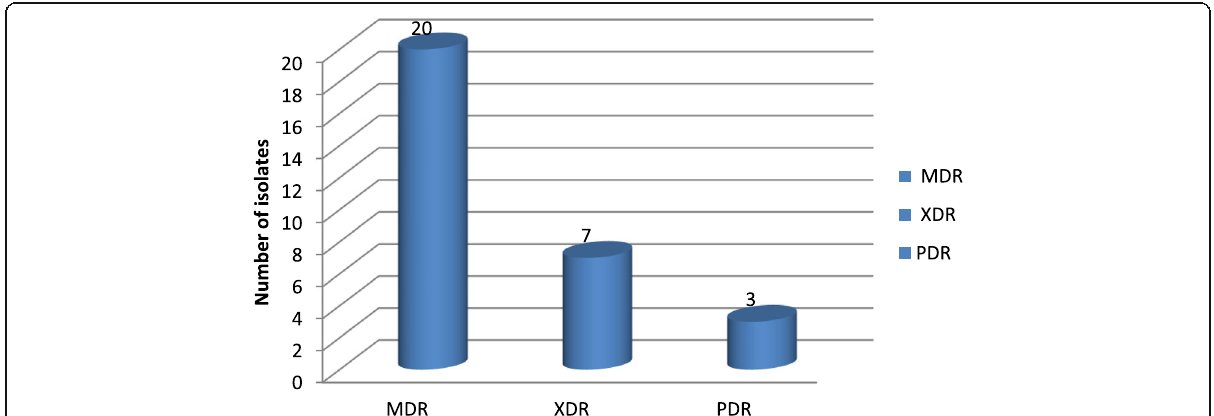
Fig. 2 Number of MDR, XDR, and PDR bacterial isolates causing wound